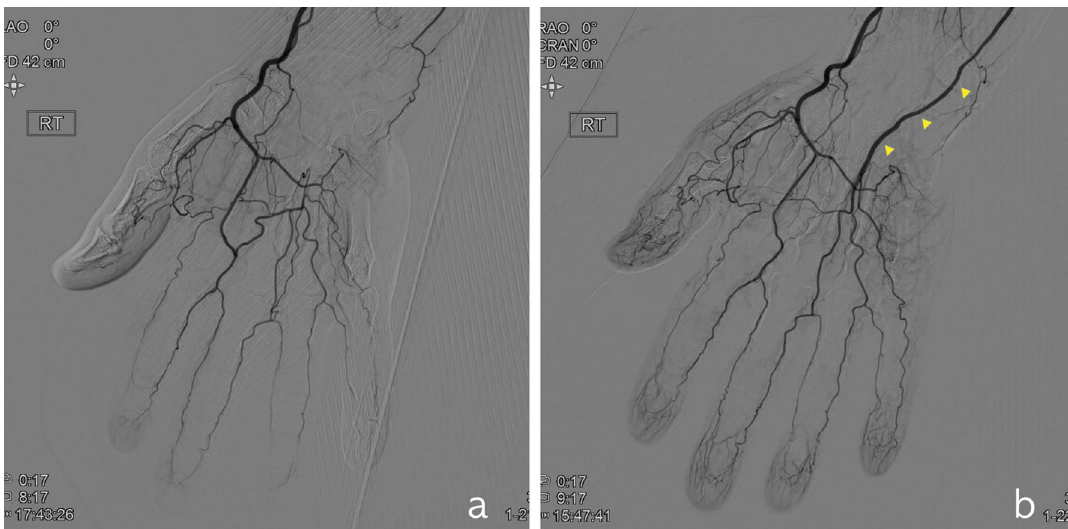
Figure 3. Conventional angiography findings. ( a ) Occlusion of the ulnar artery and decreased blood flow in the superficial palmar arch were observed. A Y-shaped DIEA interpositional graft was anastomozed to three locations, including the proximal ulnar artery, the superficial palmar arch, and the 3 rd common palmar digital artery; ( b ) a 12-month postoperative angiogram shows patent blood flow in the graft (yellow arrows) and increased blood flow in the digital